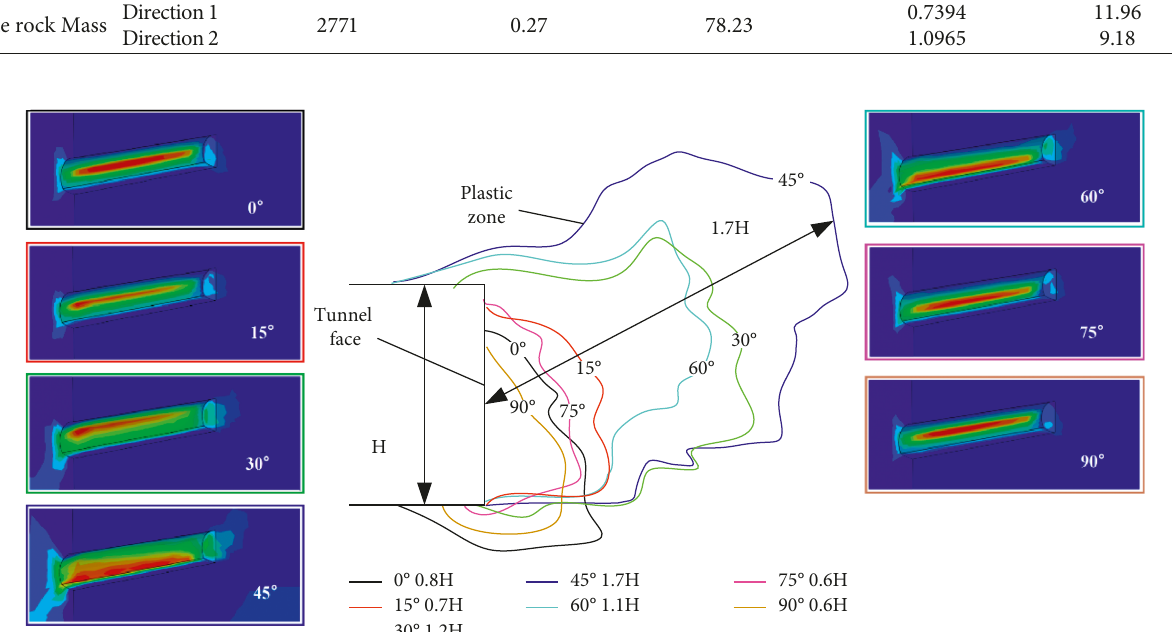
Figure 18: Tunnel plastic zone and plastic zone sketch ahead the tunnel under different dip